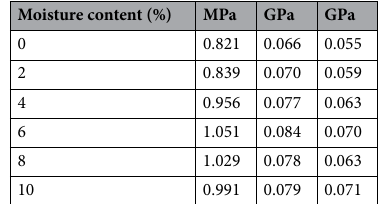
Table 1. The uniaxial compression test results for the coal briquette samples with different moisture contents.